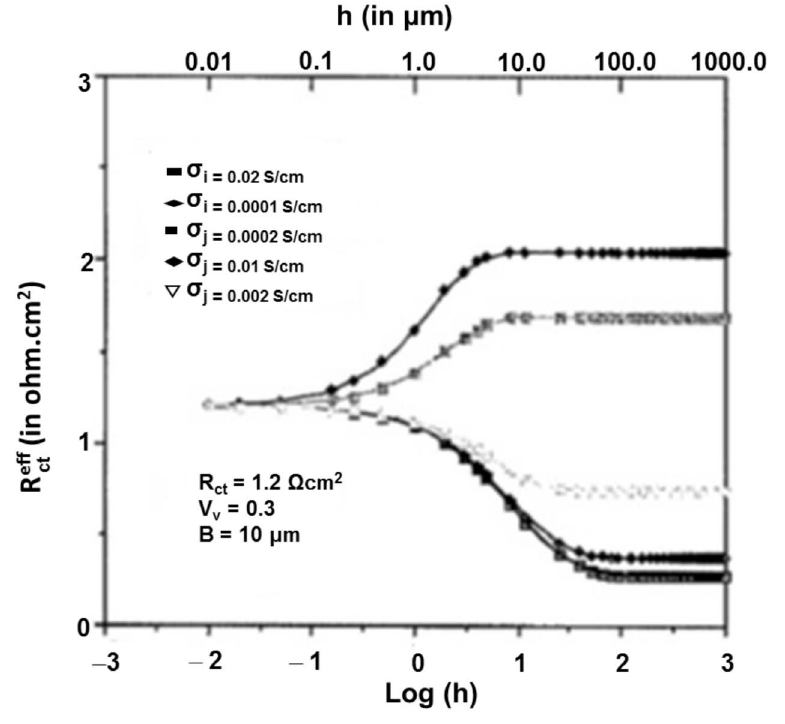
Figure 7. Correlation between effective charge transfer resistance and electrode thickness of different ionic conductivity (adapted from ref.